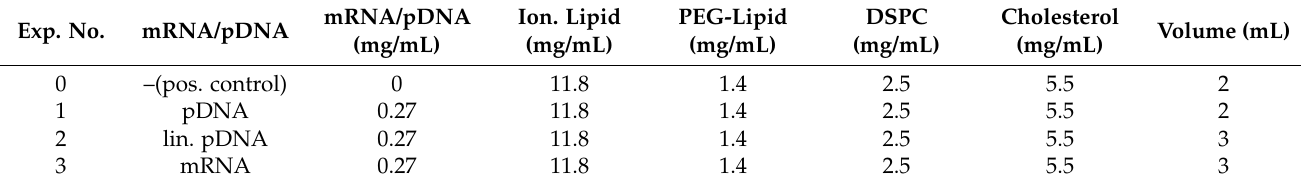
Table 10. Experimental plan for the LNP formulation.